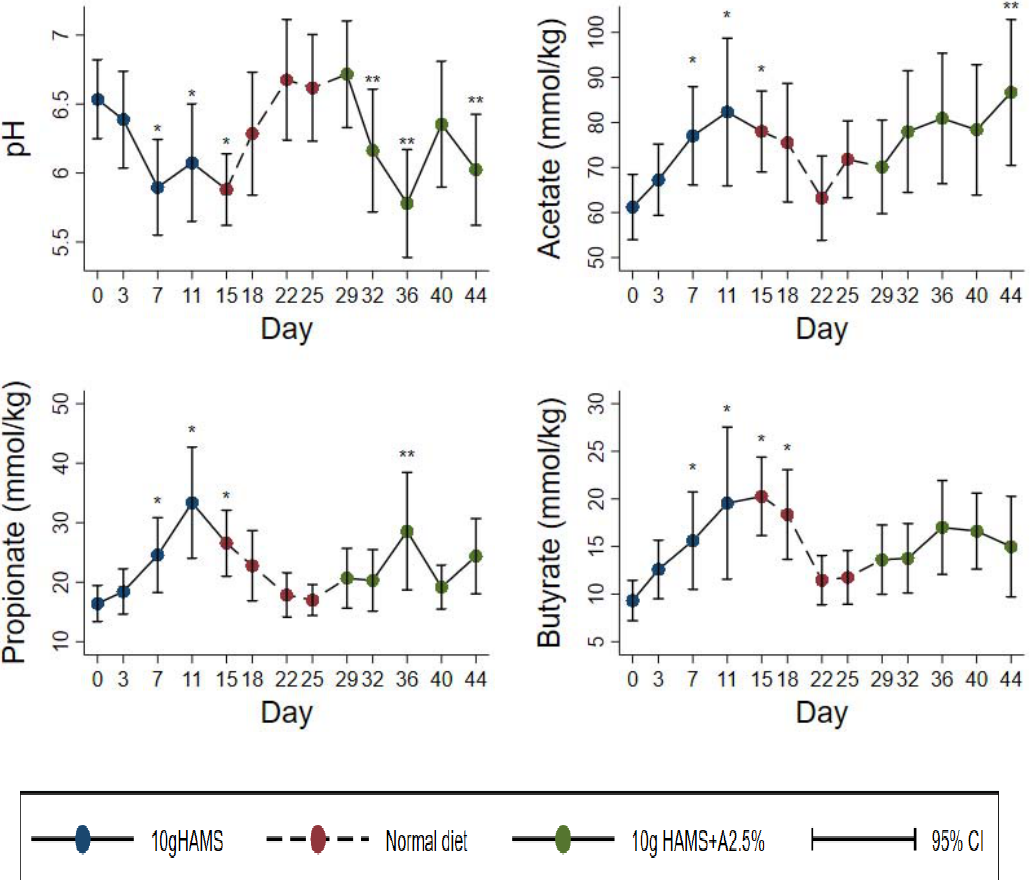
Figure 2. Fecal parameters of RS fermentation (pH and SCFA) in all participants over the study period (n = 20). Values are mean and 95% CI. * Significantly higher versus day 0: p < 0.05. ** Significantly higher versus day 29: p < 0.05.